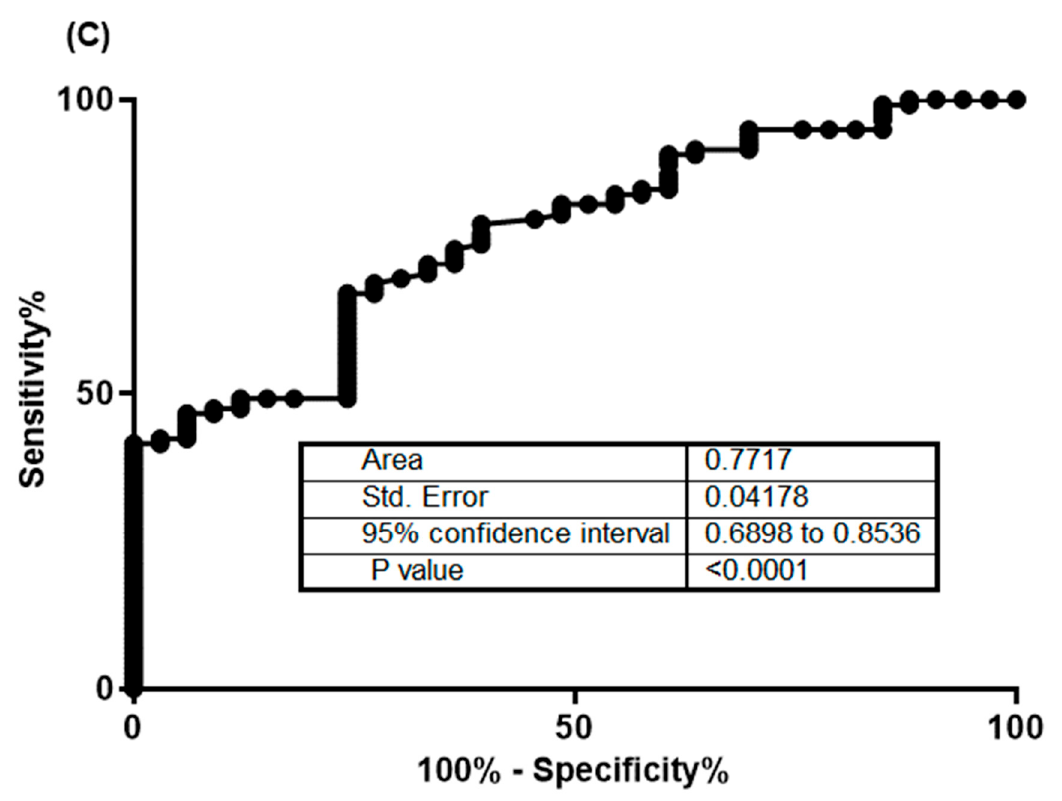
Figure 1. Neopterin concentrations in plasma at admission to hospital ( A ) in children with CM (black dots) compared to children with SNCM (grey dots), ( B.1 ) children who died (red dots) compared to those who survived (green squares), ( B.2 ) children who died compared to those who survived in the CM group (blue squares) and in the SNCM group (green dots), and ( C ) ROC curve analysis predicting neopterin’s performance in differentiating fatal from non-fatal cases on the day of admission to hospital.